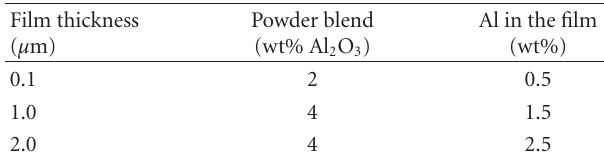
Table 4: Measured electrical properties for ZnO:Al 2 O 3 films grown from powder source.